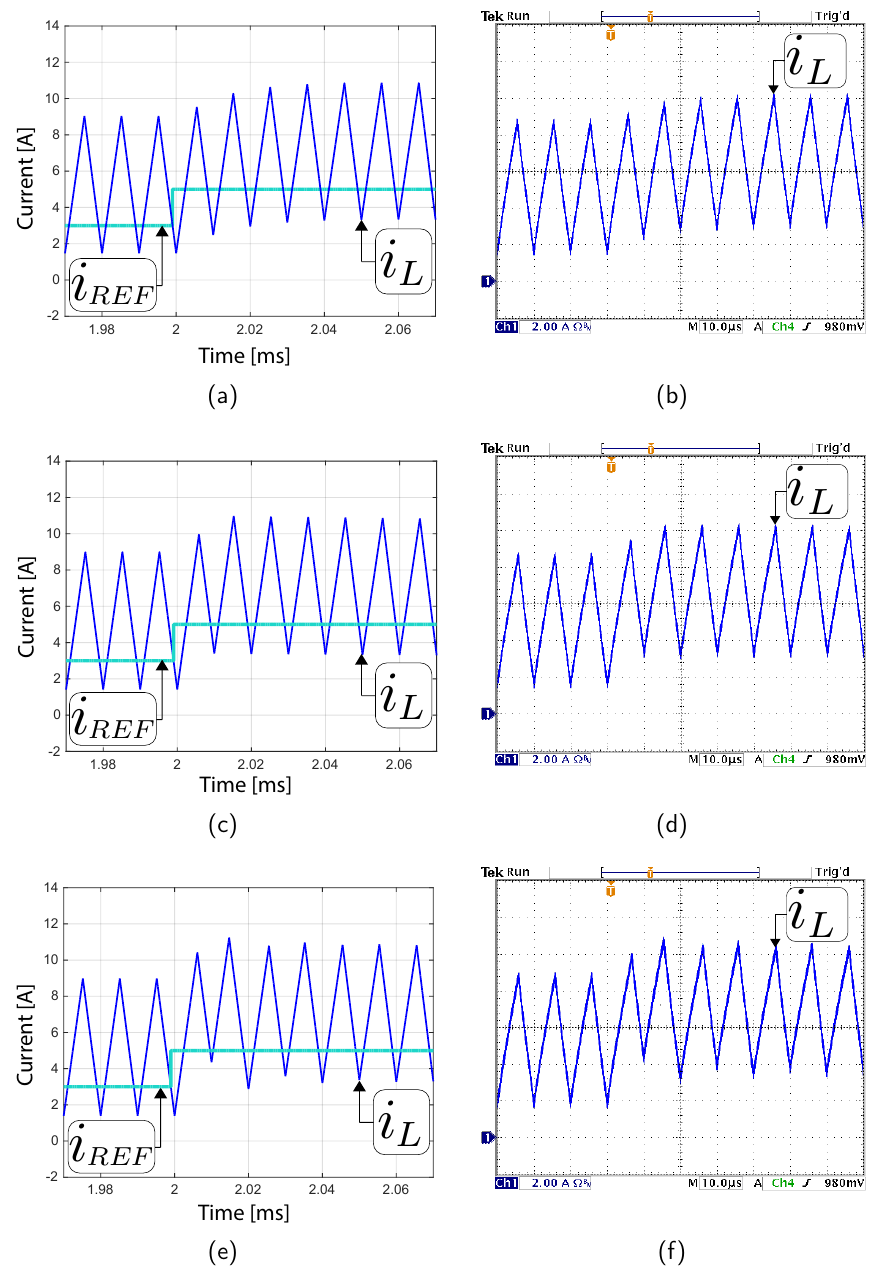
Figure 4. Inner current loop step responses, at t = 2 ms the current reference is increased from 3 A to 5 A: ( a ) PSIM simulation, w = 0.5; ( b ) experimental measurement, w = 0.5; ( c ) PSIM simulation, w = 0.0; ( d ) experimental measurement, w = 0.0; ( e ) PSIM simulation, w = measurement, w = −